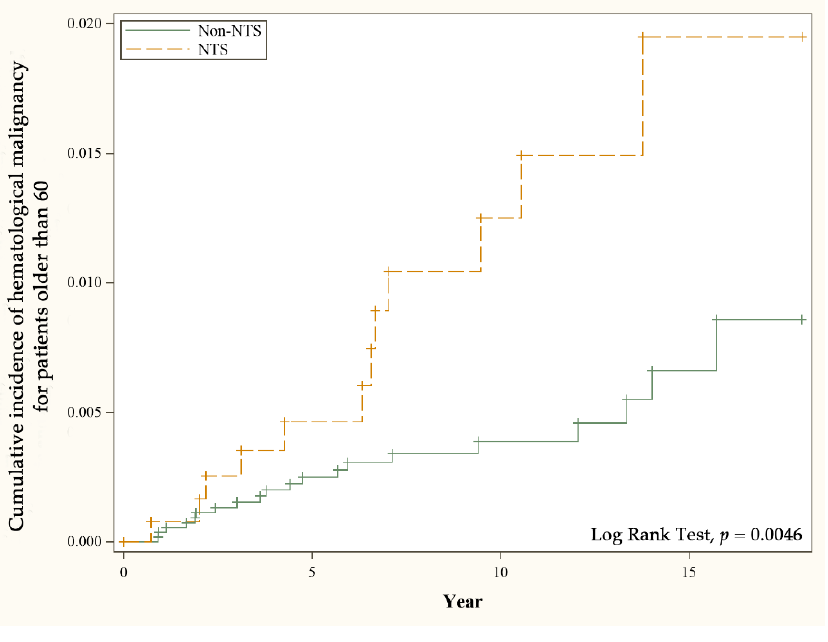
Figure 2. Cumulative incidence of hematological malignancy for patients older than 60 with and without nontyphoidal salmonellosis. Table 3. Incidence rate and hazard ratio of hematological malignancy in different